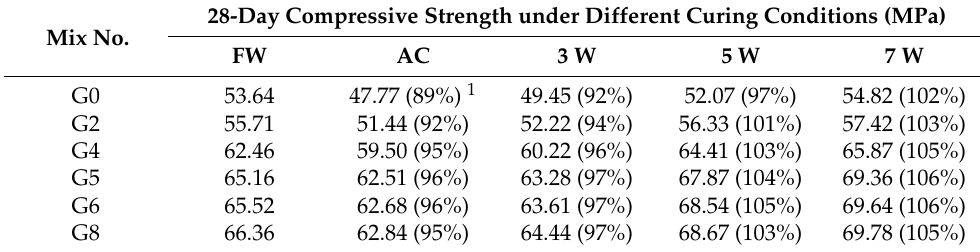
Table 6. The 28-day compressive strength of HSLWC under different curing conditions. 28-Day Compressive Strength under Different Curing Conditions Mix No.